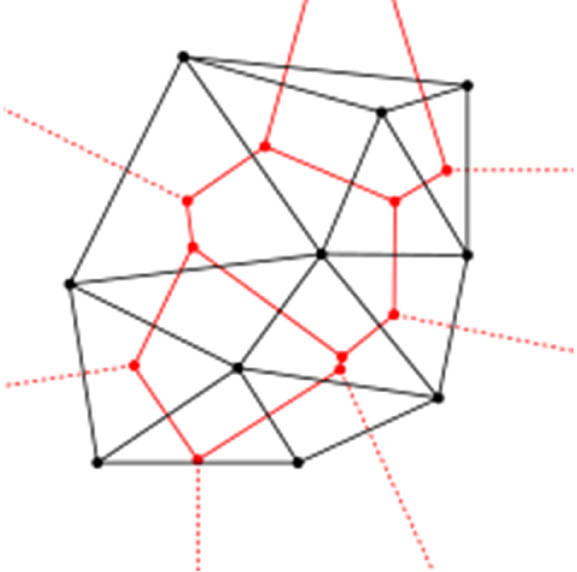
Figure 3. Visualization of Delaunay triangulation .